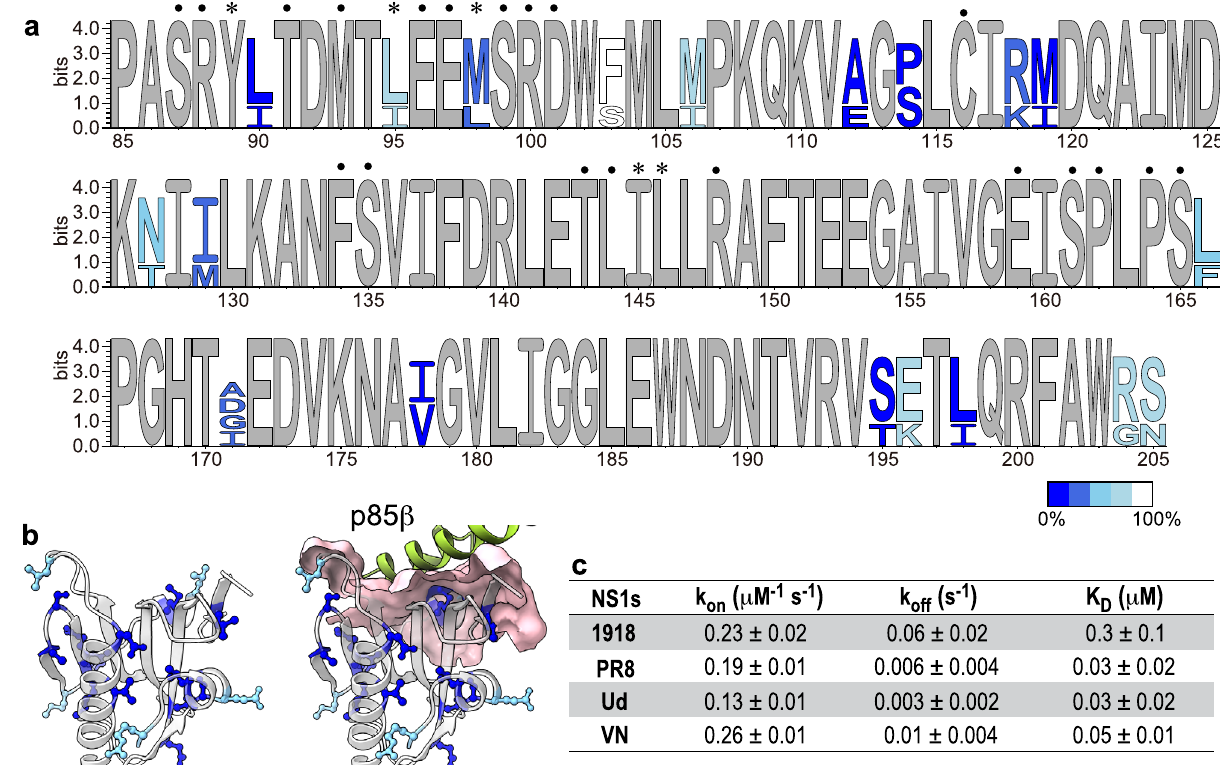
Fig. 1 | Strain-speci fi c mutations of NS1s. a The sequence logo of four NS1s. Completely conserved residues are in gray. Mutated residues are color coded according to the relative solvent accessible surface area. Asterisks and black fi lled circles represent the core and rim interface residues, respectively. b (left panel) Positions of strain-speci fi c mutations are shown as ball-and-sticks. Partially or